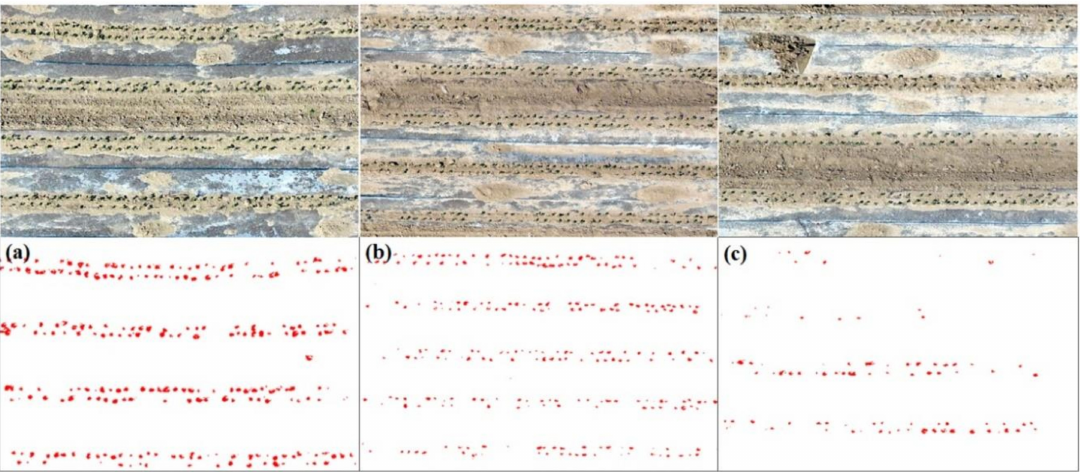
Figure 5. Zoomed-in areas of the mosaic and classification image, the upper images are the true-color mosaic images, and the bottom images are the corresponding classification results, red points are cotton plants. ( a – c ) are regions presented in Figure 4a.